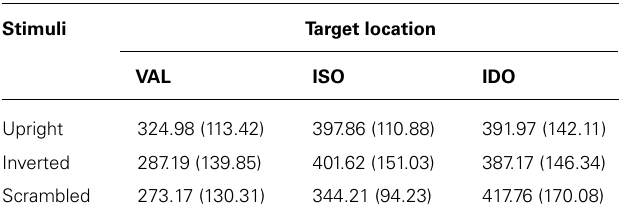
Table 1 |Adults’ mean latencies (SD) expressed in msec for the different target locations toward the upright, inverted, and scrambled faces.